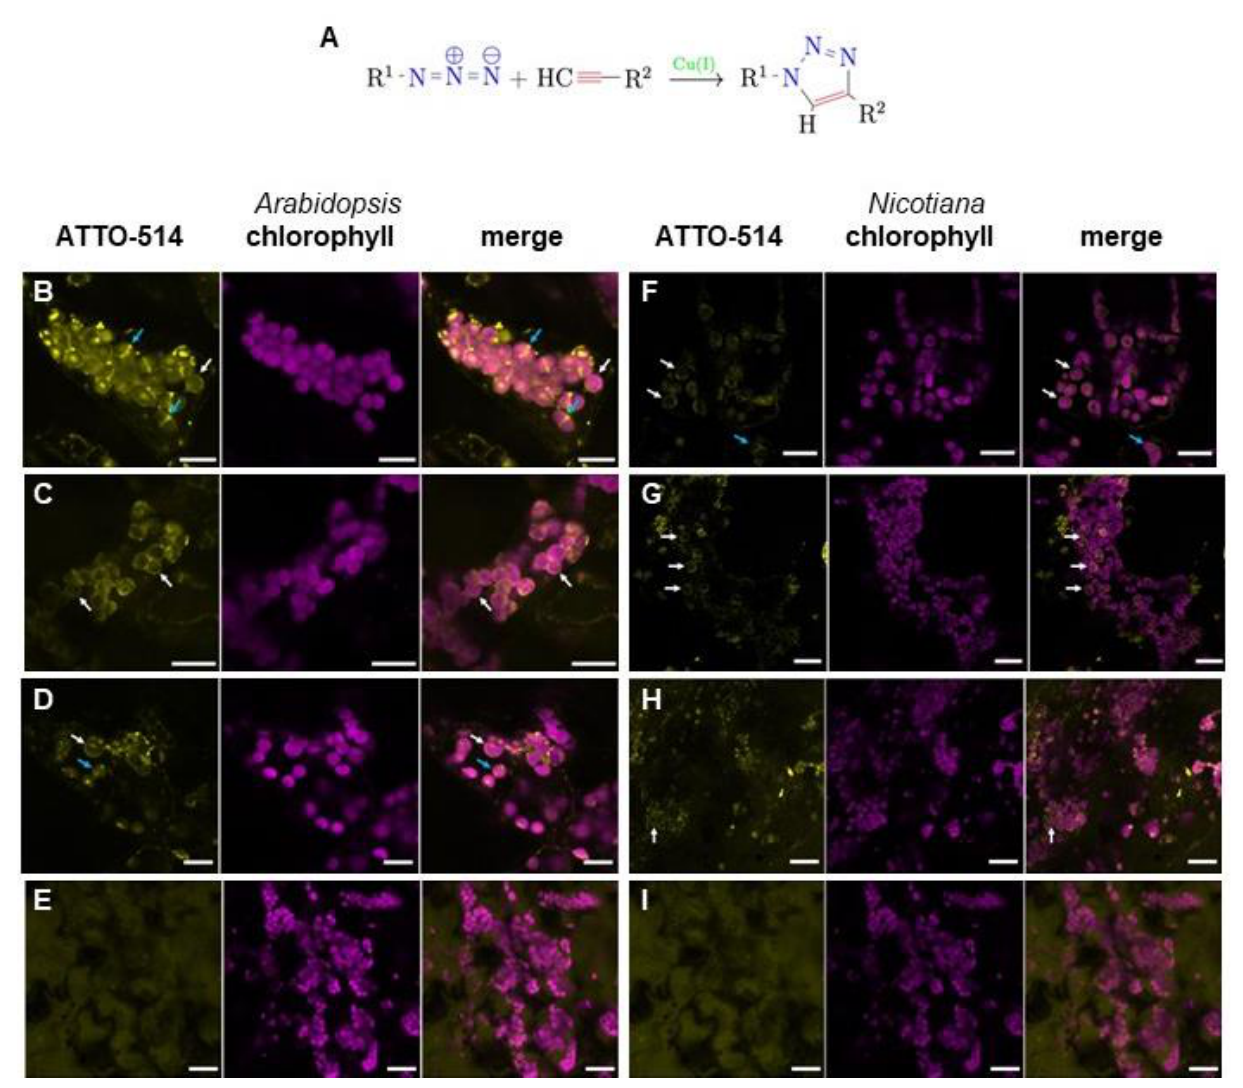
Figure 2. Chloroplasts of Arabidopsis thaliana and Nicotiana benthamiana cells are surrounded by PGN-like structures. ( A ) General coupling scheme of azide amino acid derivatives (R 1 ) with ethenylated fluorescent dyes (R 2 ) via click chemistry as used in this study. ( B – E ) Fluorescence microscopic images of Arabidopsis cells after click chemistry reactions of ATTO 514-Alkyne with ( B ) ADA (scale bar 10 µm), ( C ) ALA (scale bar 15 µm), ( D ) ALL (scale bar 10 µm), and ( E ) ADL (scale bar 20 µm). ( F – I ) Fluorescence microscopic images of tobacco cells after click chemistry reactions of ATTO 514-Alkyne with ( F ) ADA (scale bar 15 µm), ( G ) ALA (scale bar 20 µm), ( H ) ALL (scale bar 20 µm), and ( I ) ADL (scale bar 20 µm). Left picture in a series of three pictures is always ATTO-514 fluorescence (ATTO-514), middle picture is chlorophyll autofluorescence (chlorophyll), and right picture is the merged image. White arrows indicate chloroplasts surrounded by fluorescent ring-like structures, blue arrows highlight structures crossing chloroplasts like a division plane.